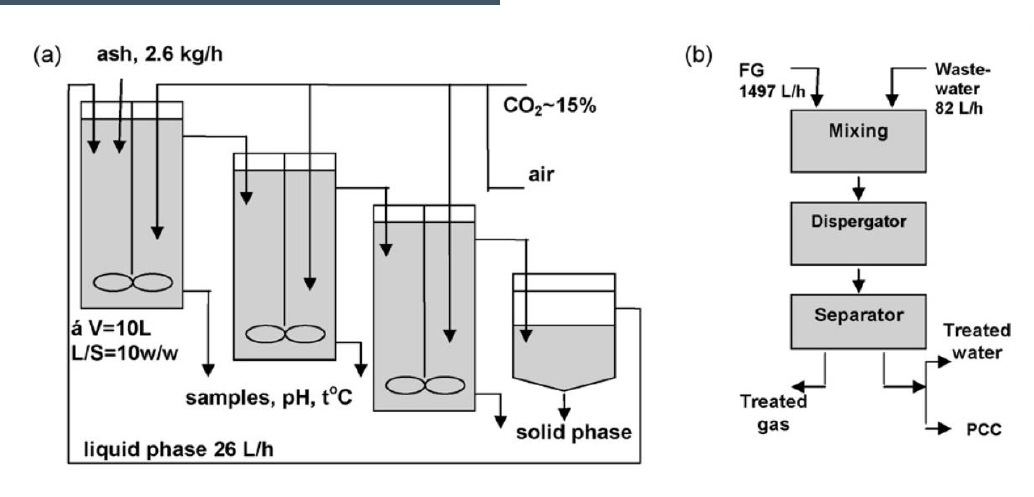
Figure 5. Experimental cascading reactors for carbonation of oil-shale ash suspension (a) and alkaline wastewater (b). Reprinted from Journal of Hazardous Materials, Vol. 174, Uibu et al. [98], 209-214, Copyright 2009, with permission from